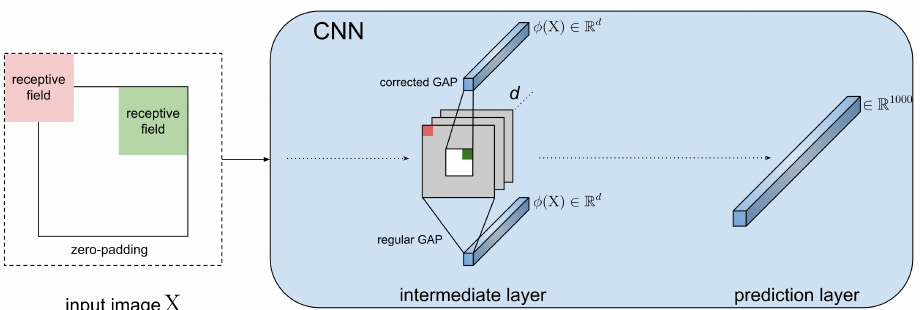
Figure 4. Examples of albatross images and their respective scale concept measures r = S b used for learning the regression.